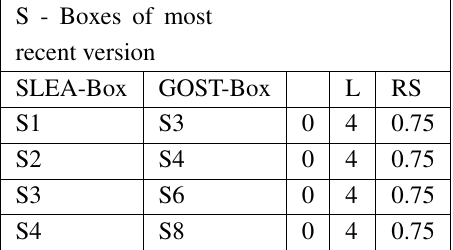
Table 6. Robustnessof GOST block cipher